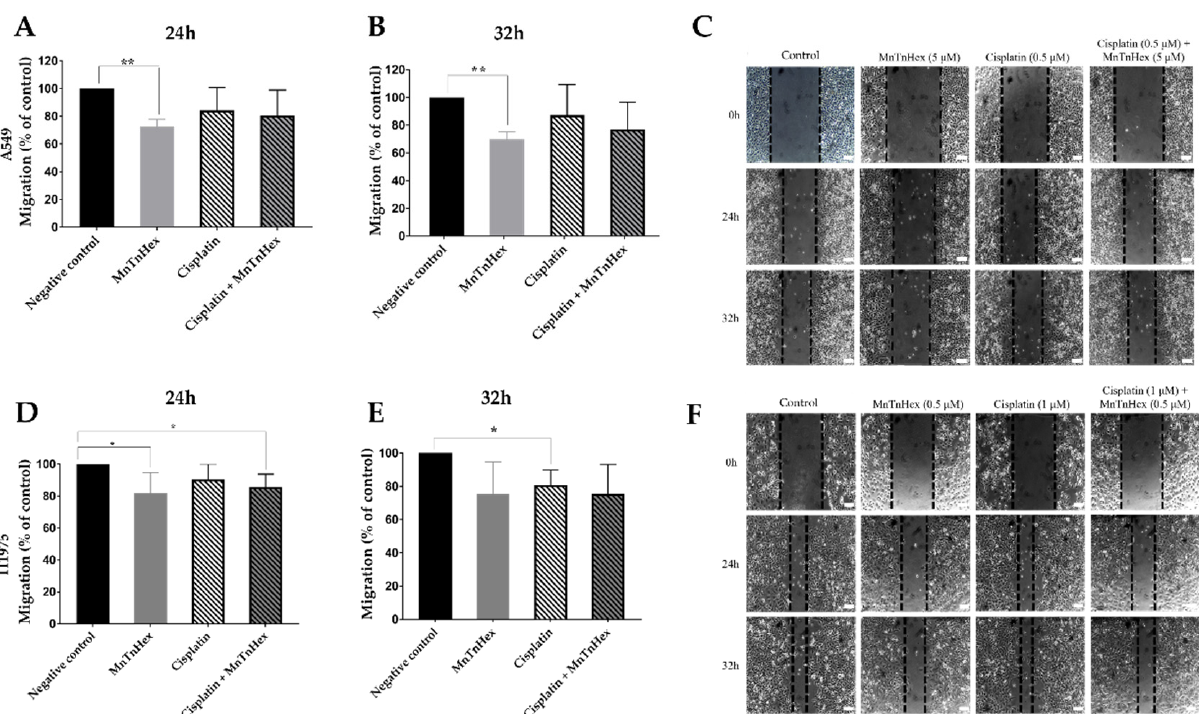
Figure 6. Effect of MnTnHex alone or combined with cisplatin on the collective migration of NSCLC cells. Cell migration was evaluated by wound-healing assay using MnTnHex (5 μ M) and/or cispla- tin (0.5 μ M) in A549 cells at ( A ) 24 h and ( B ) 32 h. ( C ) Representative microscopy images of the